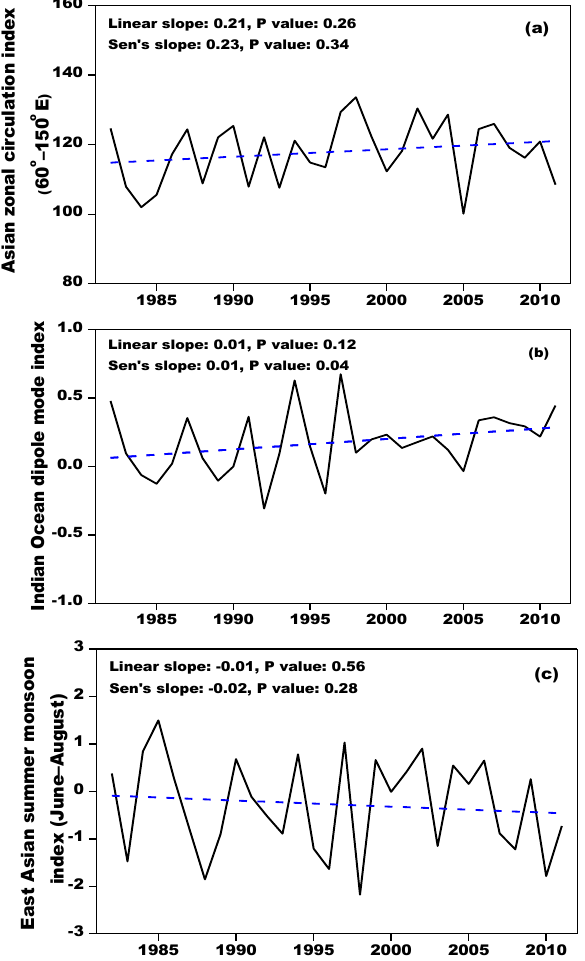
Figure 9. Linear and non-parametric trends of westerlies, the In- dian monsoon and the east Asian summer monsoon during the pe- riod 1982–2011, revealed prospectively by the Asian zonal circula- tion index, Indian Ocean dipole mode index and east Asian summer monsoon